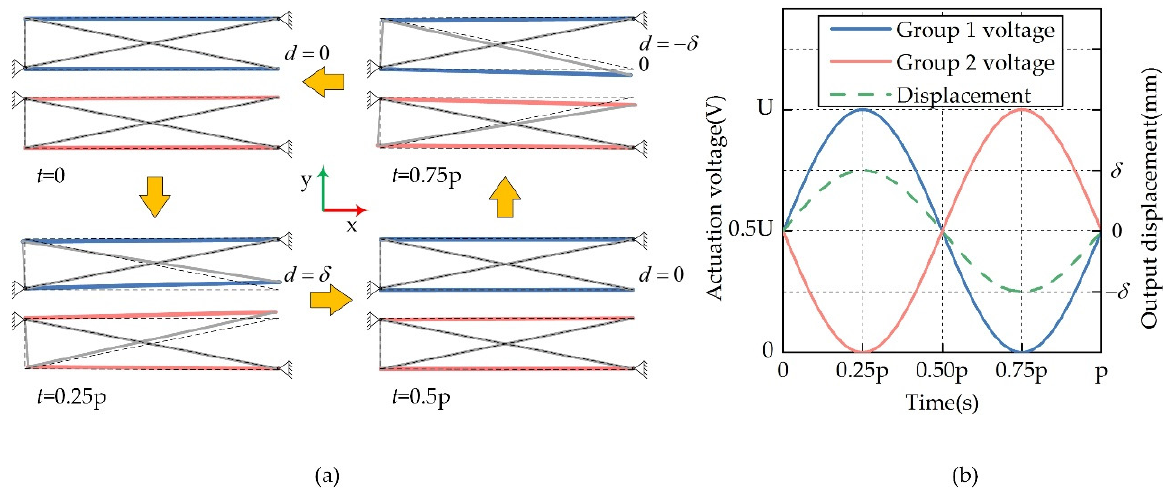
Figure 3. Operational principle of the actuator: ( a ) Output displacement of the actuator; ( b ) Actuation voltages of the piezoelectric stacks.